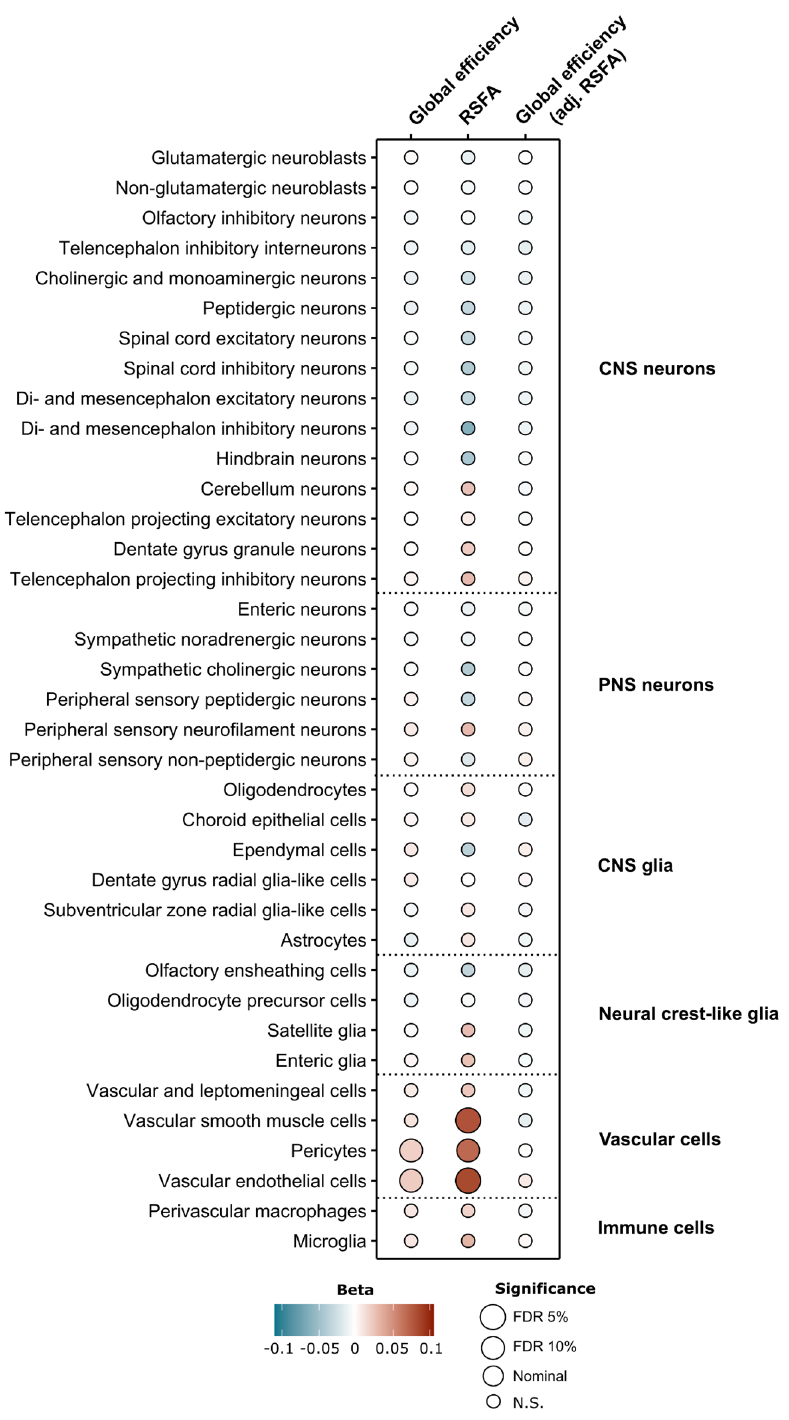
Figure 3. Bubbleplot of mouse nervous system single-cell RNA enrichment analyses for GWAS of global efficiency, resting state fluctuation amplitudes (RSFA) and global efficiency adjusted for RSFA. CNS, central nervous system; PNS, peripheral nervous system; FDR, false discovery rate; N.S.,